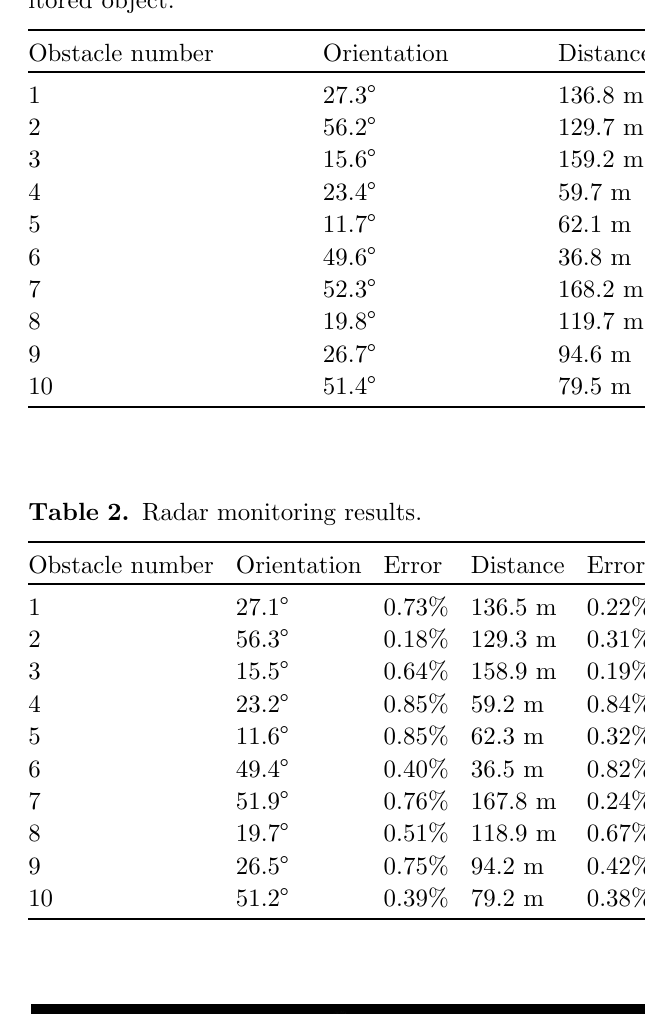
Table 1. Actual orientation and distance of the mon- itored object.